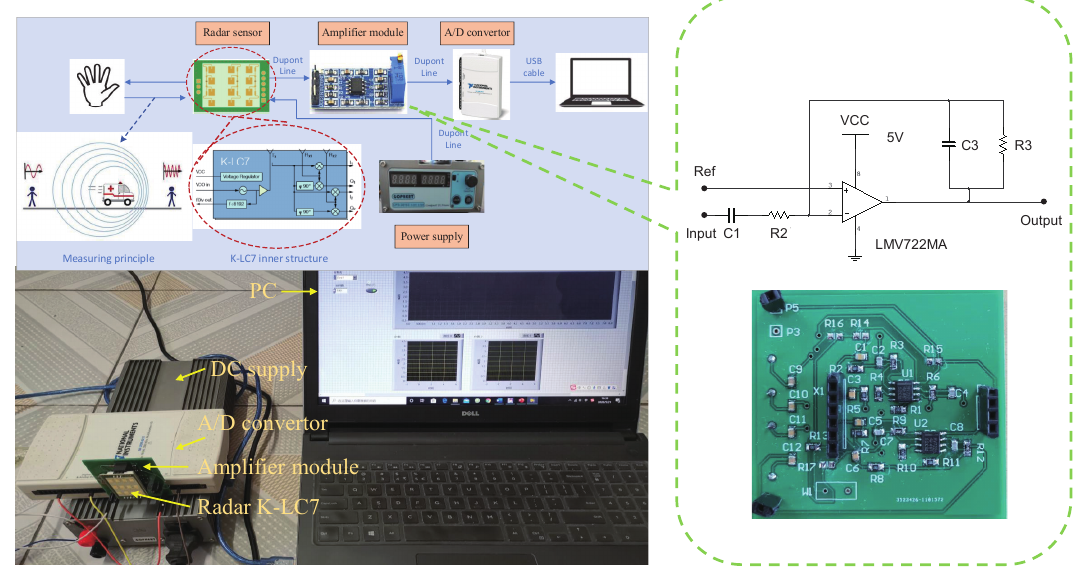
Figure 5. The entire structure of the prototype radar